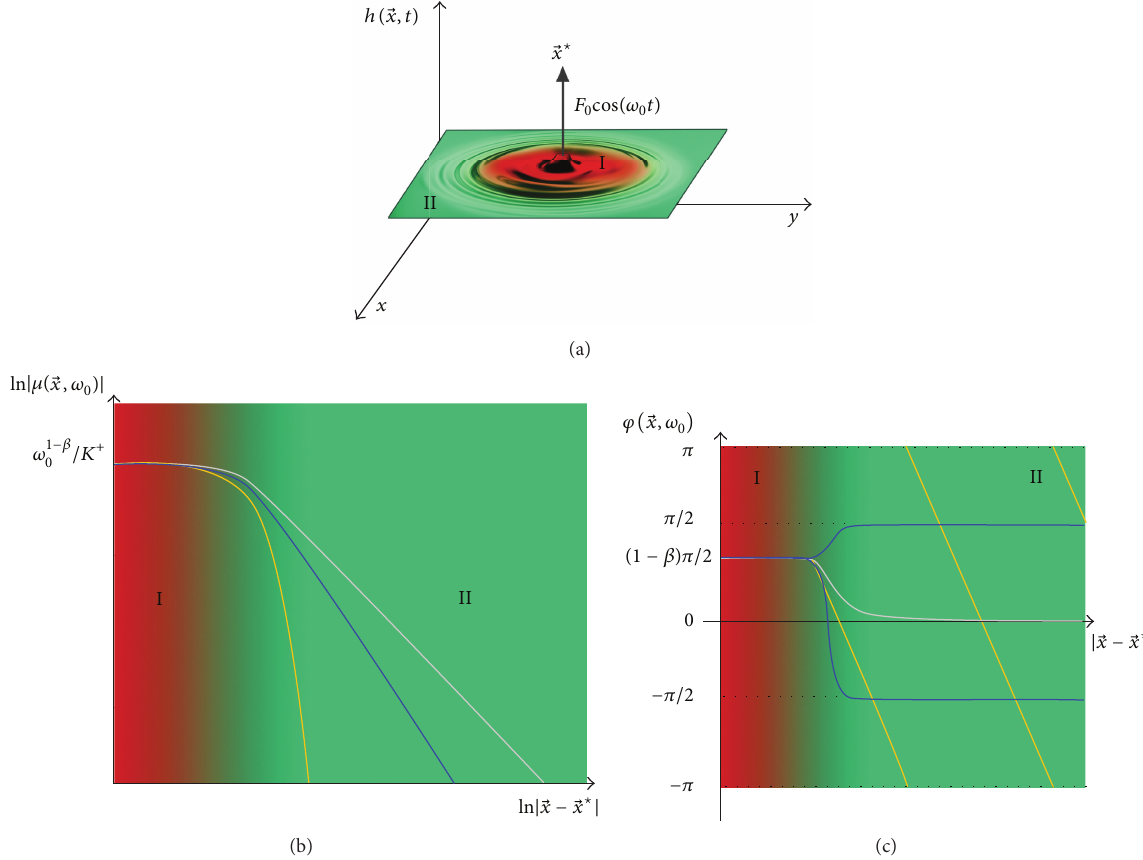
/𝐾 + holds for any kind of 0